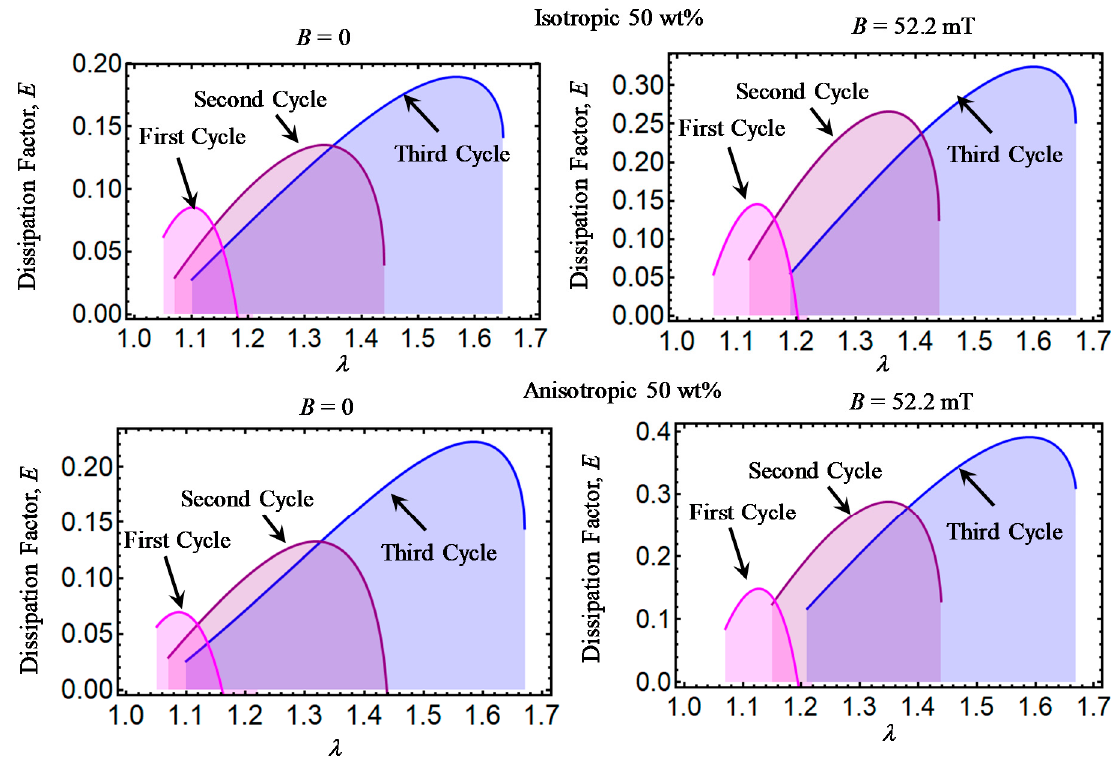
Figure 8. Dissipation factor curves for magnetorheological material samples made with a concentration of 50 wt% of CIPs.